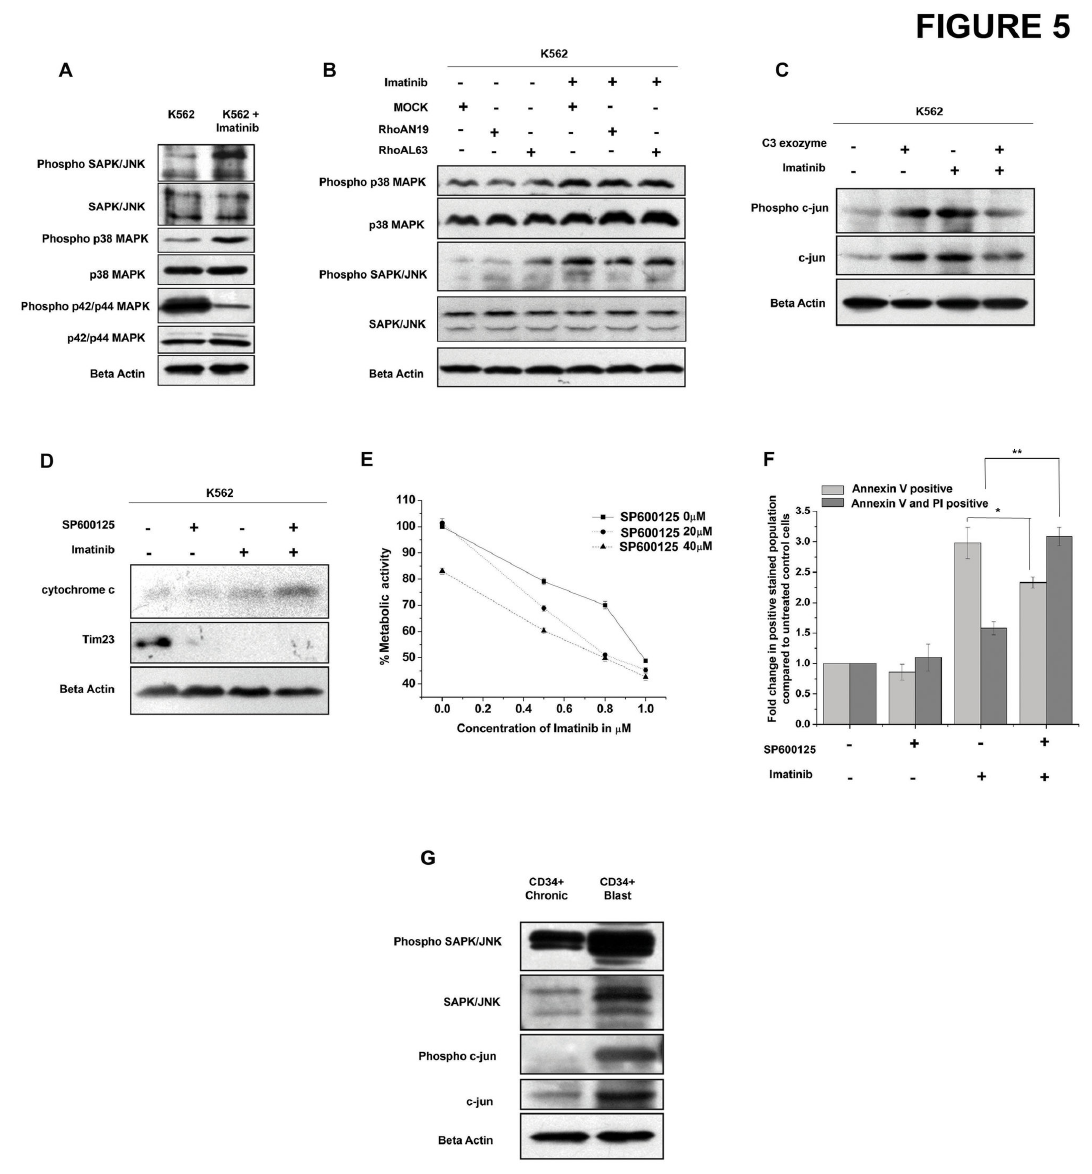
Figure 5. Inhibition of p210 Bcr-Abl leads to increased JNK activity. (A) K562 cells were treated with imatinib with 1µM for 24 hr and the levels of phosphorylated p38 MAPK, p38MAPK, phosphorylated SAPK/JNK, SAPK/JNK phosphorylated p42/44 MAPK, p42/44 MAPK was assessed. Beta actin was used as a loading control. (B) K562 cells were transfected with MOCK, RhoAN19 or RhoAL63 vectors followed by treatment with/without 1µM imatinib for 24 hr. The levels of phosphorylated p38 MAPK, p38MAPK and phosphorylated SAPK/JNK, SAPK/JNK was assessed by western blotting. (C) K562 cells were treated with imatinib, C3 exozyme or both and the activity of SAPK/JNK pathway was assessed by looking into the phosphorylation of c-jun. (D) K562 cells were treated with imatinib, SP600125 or both and the level of cytochrome c released from the mitochondria was analysed in the mitochondria free cytosolic fraction. Tim23 was used to estimate mitochondrial contamination in the mitochondria free cytosolic preparations while beta actin was used as a loading control. (E) K562 cells were treated with the indicated concentrations of imatinib and SP600125 either singly or in combination for 24hrs. The percentage metabolic activity was assessed by MTT assay. Data shows the mean percent metabolic activity for individual treatments in three separate experiments. (F) K562 cells were treated with 1µM imatinib, 20µM SP600125 or both and apoptosis was measured by staining the cells with Annexin V and PI. Graph shows the change in Annexin V stained and Annexin V + PI stained population compared to untreated control cells (n=3, *p<0.037, **p<0.002). (G) Protein expression of phosphorylated SAPK/JNK, SAPK/JNK, phosphorylated c-jun and c-jun in CD34 + cells of chronic and blast phase CML. Beta actin was used as a loading control. doi: 10.1371/journal.pone.0076527.g005 PLOS ONE |